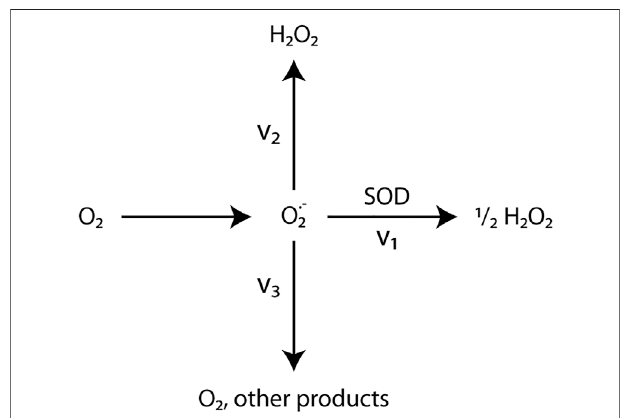
FIGURE 10 | Simpli fi ed Superoxide Pathways. Gardner et al. (2002) ’ s simpli fi ed model of O 2 − formation and decay pathways. (1) Dismutation catalyzed by SOD produces ½ molecule of H 2 O 2 per O 2 − molecule. (2) O 2 − reduction pathways that produce 1 or more H 2 O 2 molecules per O 2 − molecule. (3) Pathways that consume O 2 − , but do not produce H 2 O 2 . These pathways are poorly understood. (4) O 2 −